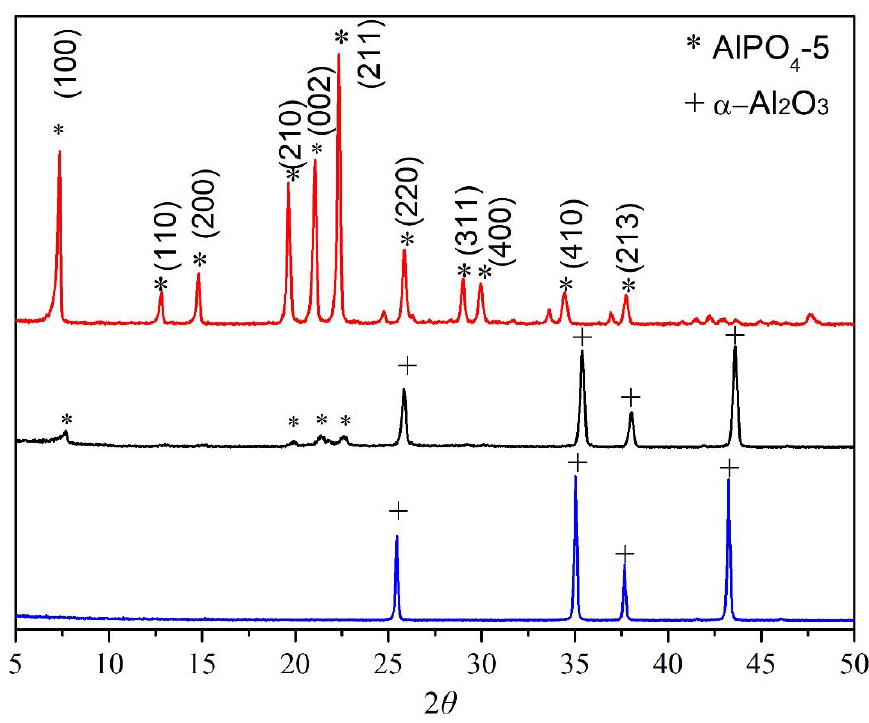
Figure 3. XRD images of AlPO 4 -5 particles being used prepare seeds, α -Al 2 O 3 substrate, and AlPO 4 -5 seeds deposited on α -Al 2 O 3 substrate.